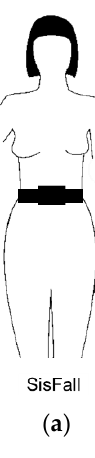
Figure 1. Location of accelerometers during the recording of the two datasets. ( a ) SisFall dataset. Two accelerometers and one gyroscope were attached to a belt around the waist. Only data from one of the accelerometers were analyzed in the present study. ( b ) FARSEEING dataset. One accel- erometer was attached to the lower back and the other on the thigh of each participant. Only data from the accelerometer on the lower back was analyzed in the present study. Sensors were selected to achieve the highest similarity with respect to sensor placement.